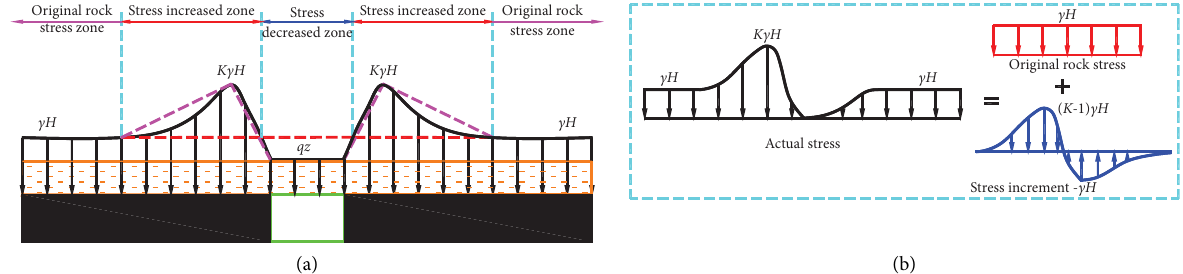
Figure 4: Stress distribution of surrounding rock: (a) stress curve; (b) stress